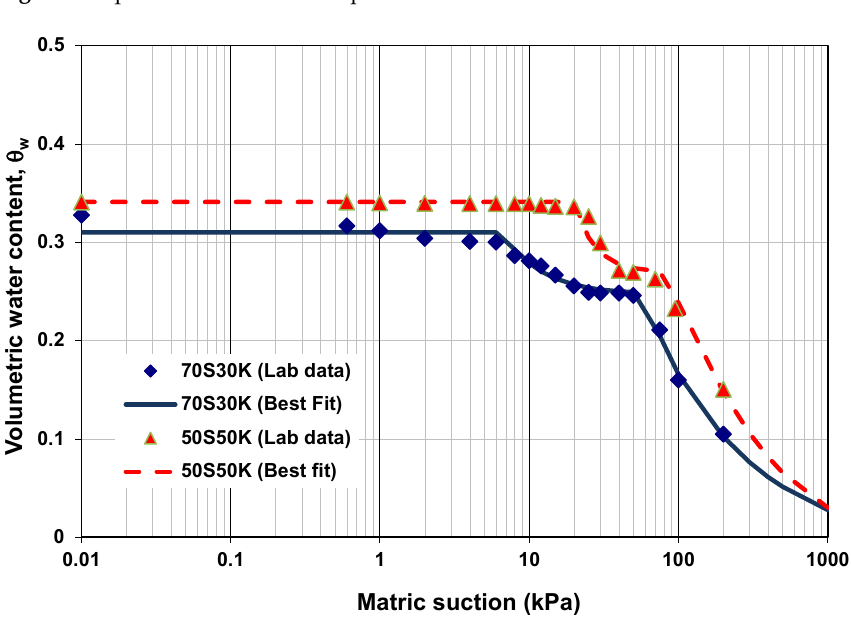
Figure 5. Equalization time of soil specimen 50S50K.